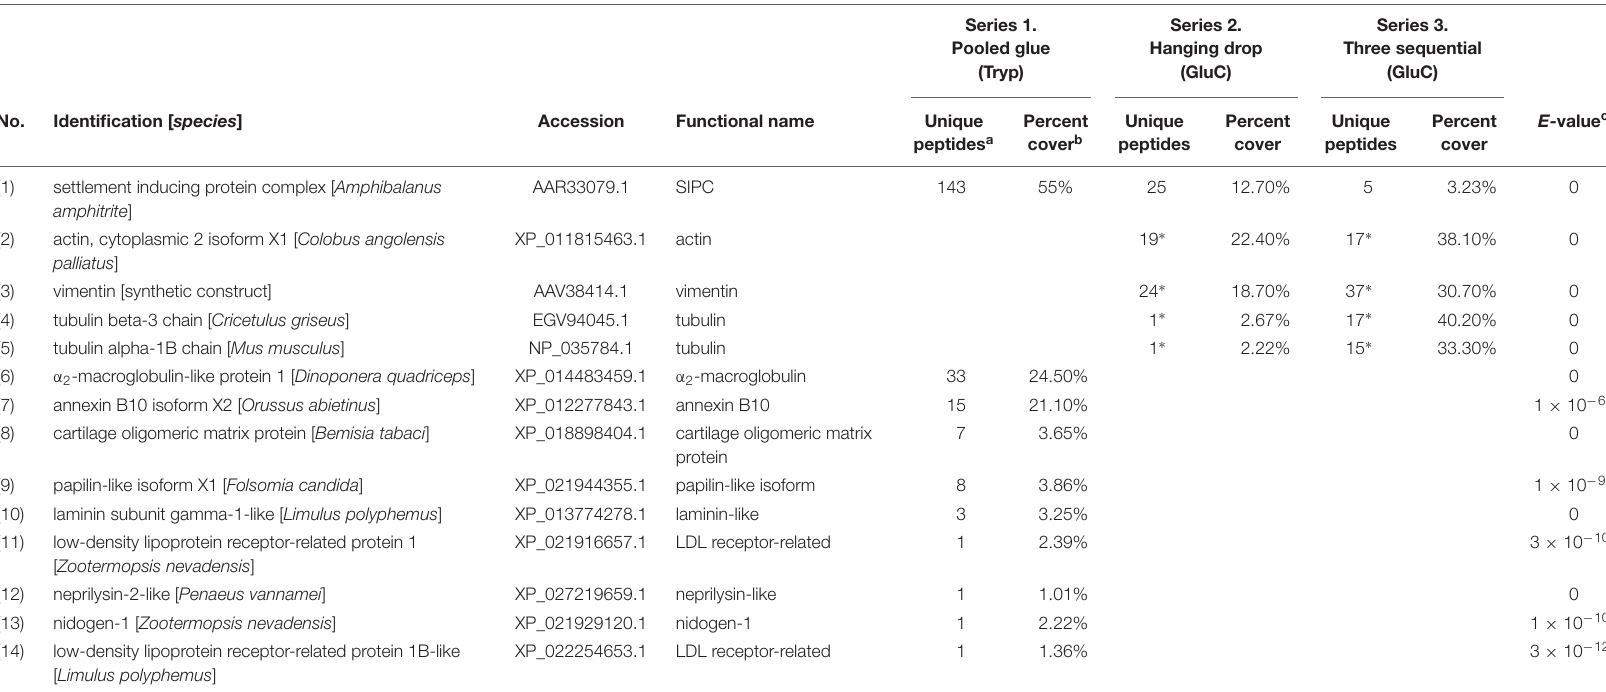
TABLE 3 | Extracellular Matrix (ECM)-related proteins detected in barnacle secretions by LC-MS/MS based on peptides identified and sequence coverage. The protein identification corresponds to the annotation with the top hit in NCBI with the based on the E -value given for the match.